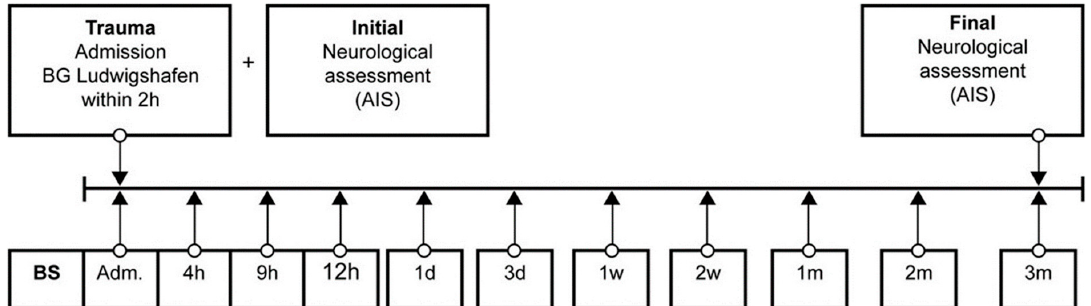
Figure 2. Standardized blood sample collection protocol. Abb.: BS = blood sample, Adm. = admission, AIS = American Spinal Injury Association (ASIA) Impairment Scale, h = hours, d = days, w = weeks, m = months.